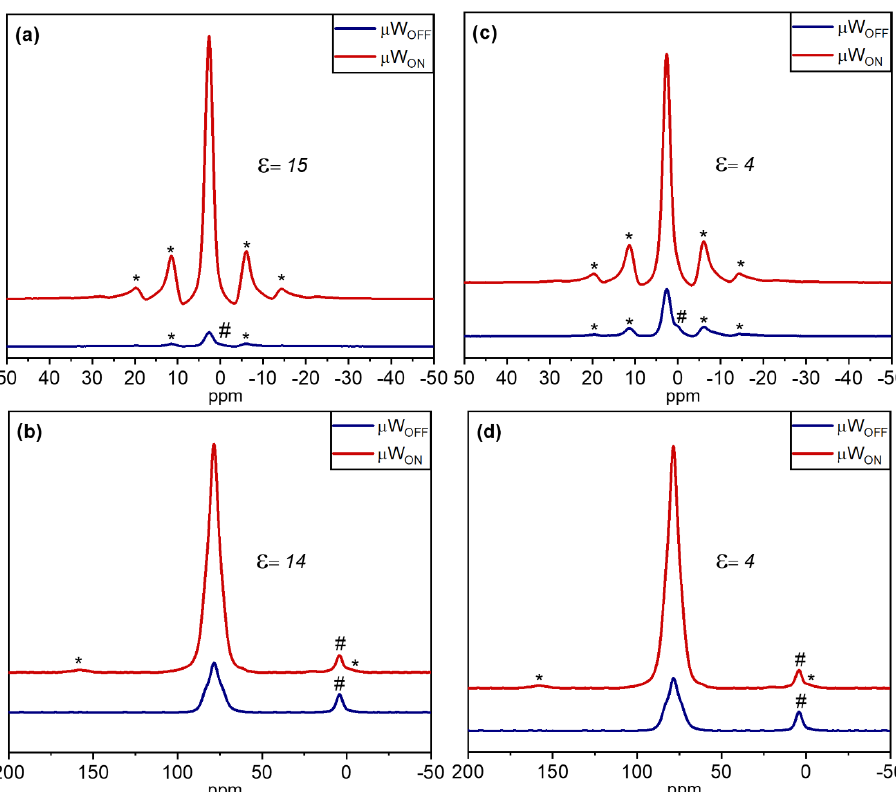
Figure 6. 1 H MAS and 1 H → 13 C CPMAS spectra of a 15 mM solution of biradicals: 3 ( a , b ) and 4 ( c , d ) in TCE. The measurements were performed at nominal 115 K in the presence (µW ON ) or absence (µW OFF ) of microwave irradiation. The # sign indicates the signal from the silicon plug near 0 ppm. The signals marked with asterisks are spinning sidebands.